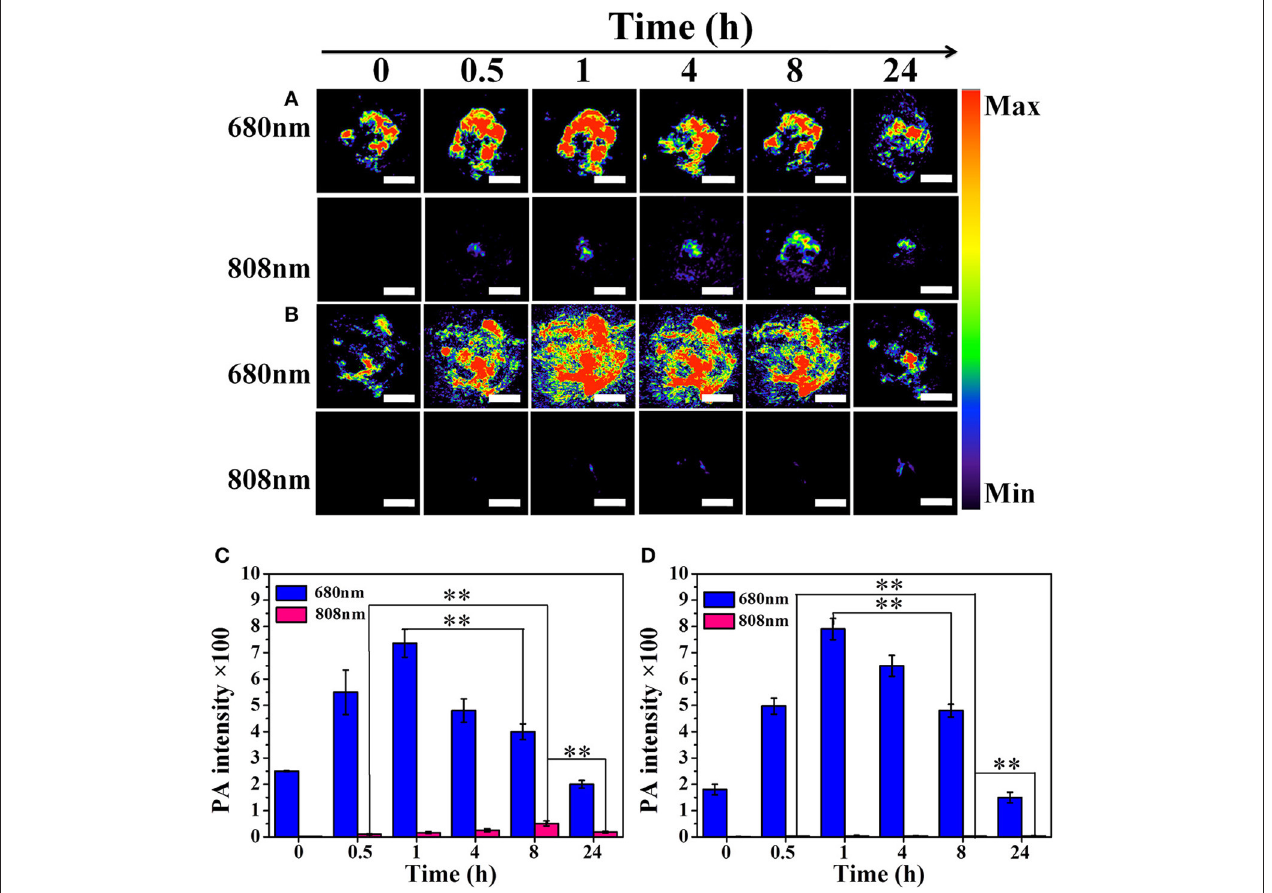
FIGURE 8 | In vivo the photoacoustic imaging (PA) of tumor-bearing mice at 0/0.5/1/4/8/24h after intravenous injection. (A) Cy-SS-MTX excited by 680nm and 808nm respectively. (B) Cy-CC-MTX excited by 680nm and 808nm respectively. (C) Semiquantitative average PA signals in the tumor site of (A) . (D) Semiquantitative average PA signals in the tumor site of (B) . Red PA signals excited by 745nm represent the drug release. (100 µ l, 80 µ g/ml for each mice, Scale bar of A,B : 5mm). (*denotes P < 0.05, **denotes P < 0.01 significant